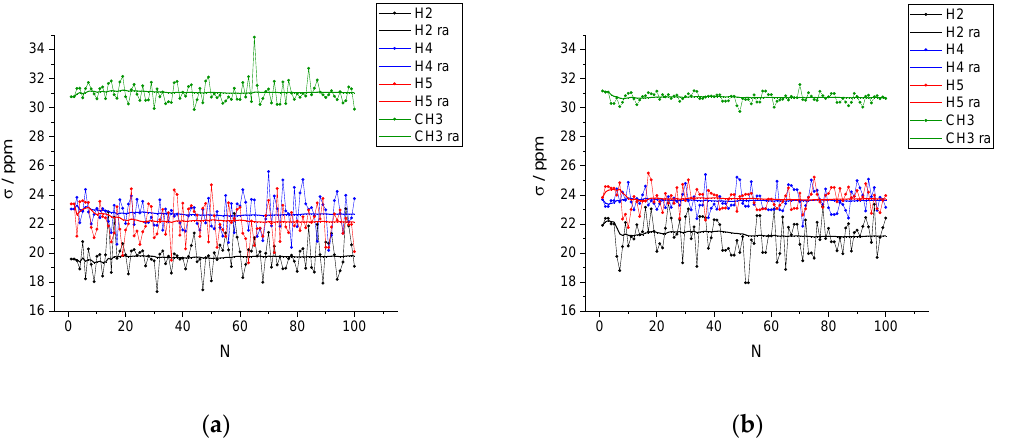
Figure 5. Instantaneous values of the isotropic shielding constant, σ , and running average (ra) for the imidazolium ring protons and the terminal methyl group of the butyl chain. ( a ) Pure IL system; ( b ) [C 4 C 1 im]Cl/water mixture with x IL = 0.01.